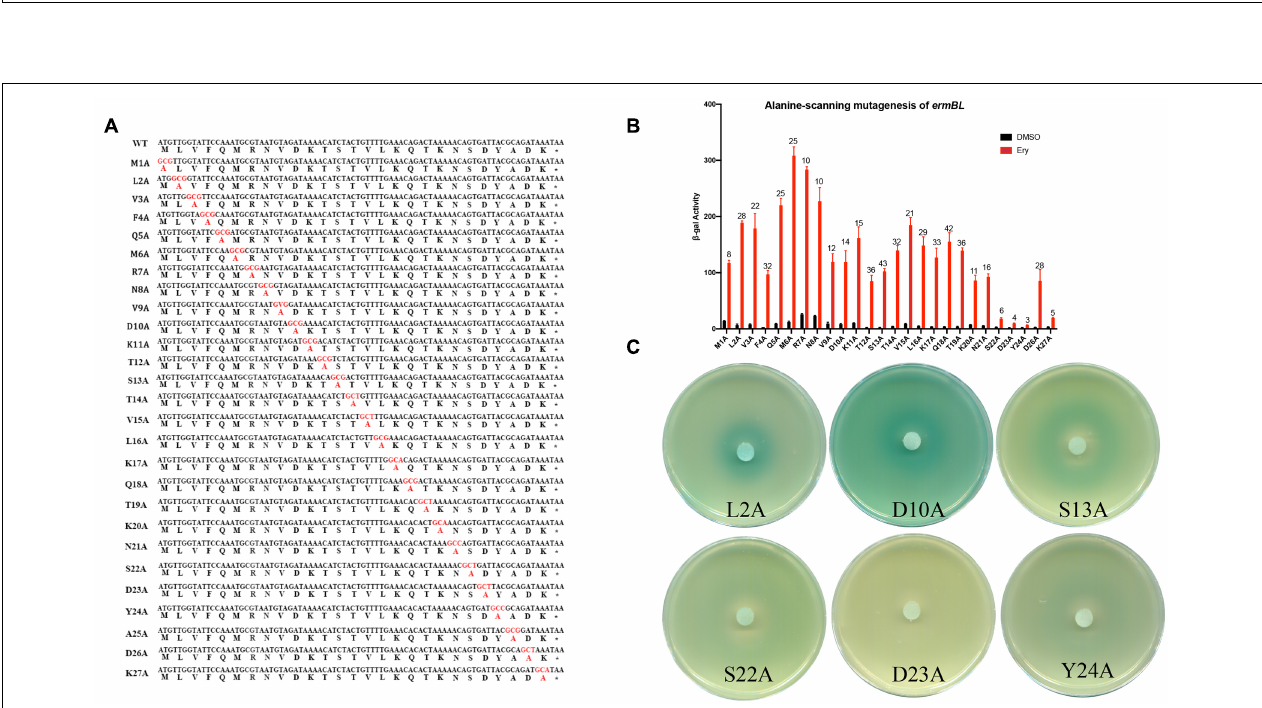
FIGURE 3 | Alanine-scanning mutagenesis of ermBL confirms key amino acids for ribosome stalling. (A) Amino acid sequences of erm BL peptide (WT) and its alanine-scanning mutations. (B,C) β -Galactosidase activity and agar diffusion assays of the degree of induction by Ery in vivo following Ala mutation of ermBL amino acid sequences. Data are mean ± SEM from three independent experiments (unpaired two-tailed Student’s t -test).